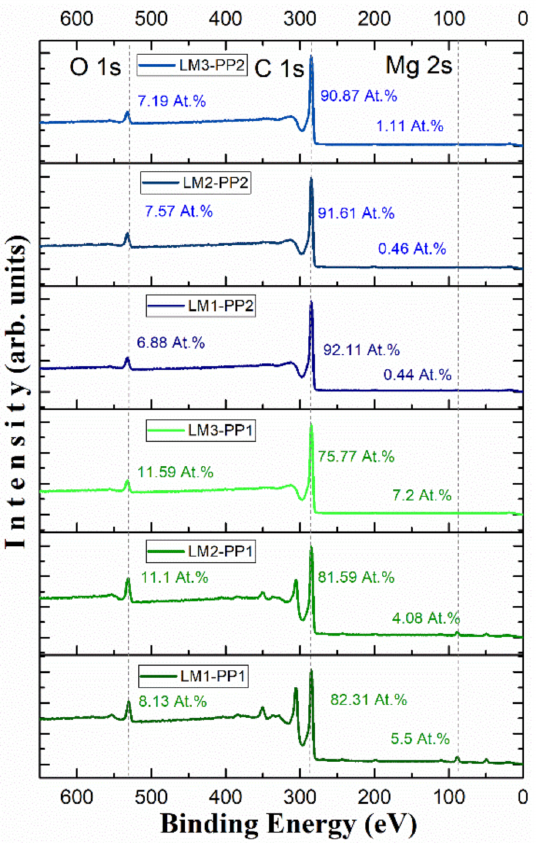
Figure 10. XPS survey spectra of LM1, LM2, and LM3 of PP1 and PP2